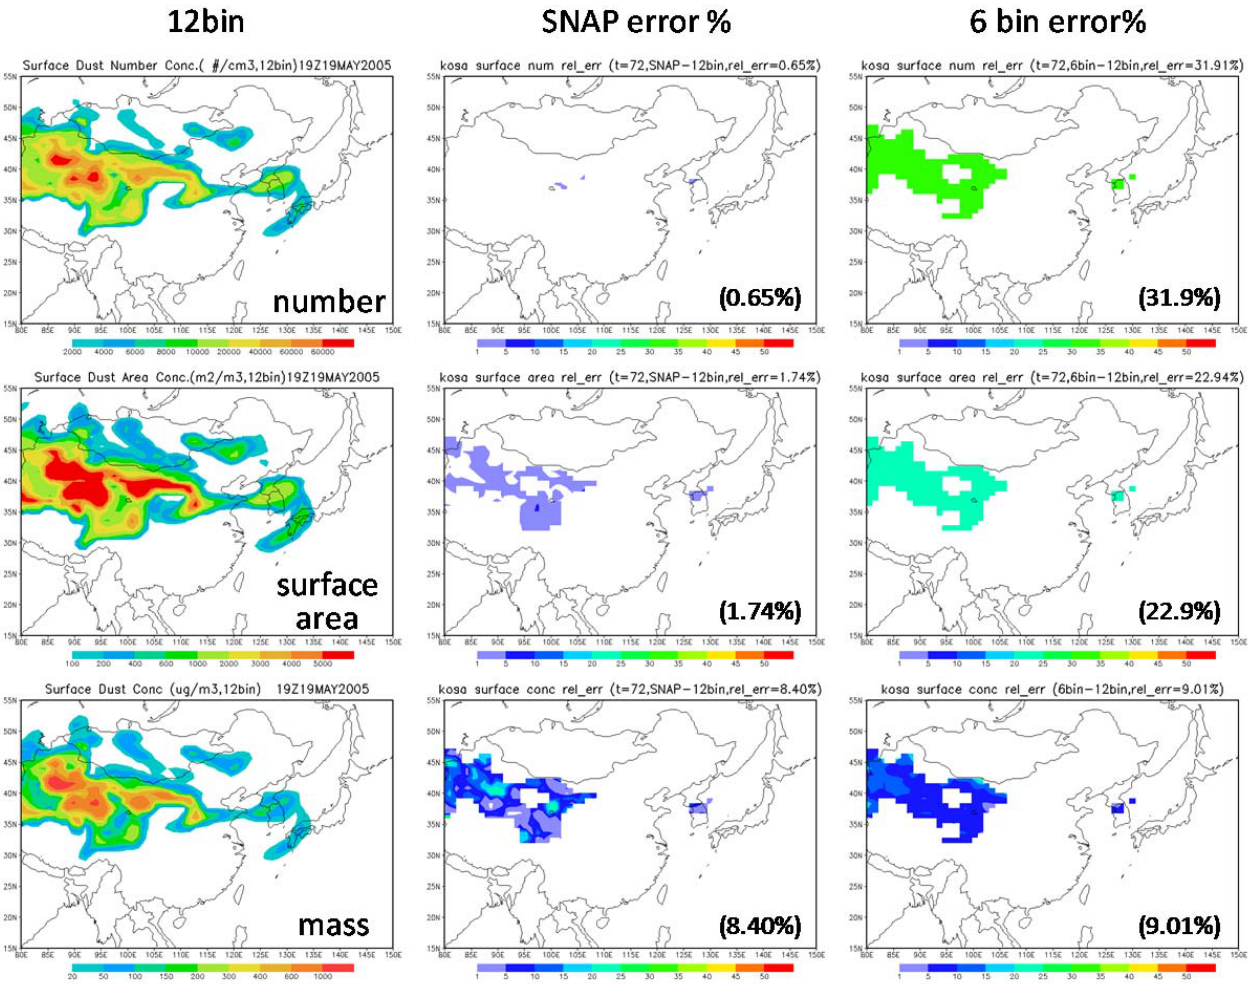
Fig. 12. Simulated near-surface mineral dust concentrations using the 12-bin sectional scheme (left column), and the difference (in %) from it using the SNAP scheme (middle) and the 6-bin sectional scheme (right). Domain mean errors are given in the parentheses on the lower right corner of each panel. From top down are the number concentration ( M 0 ), surface area concentration ( M 2 ), and mass concentration ( M 3 ). Only the areas with significant dust concentrations (mass >20µgm − 3 ) are analyzed.